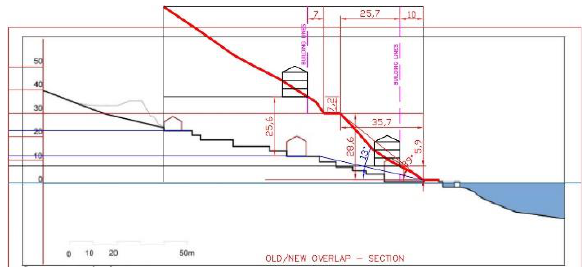
Figure 6. Section through the old/new urbanized area- overlap (Source: Kosara Kujundzic) Going back to the cultural